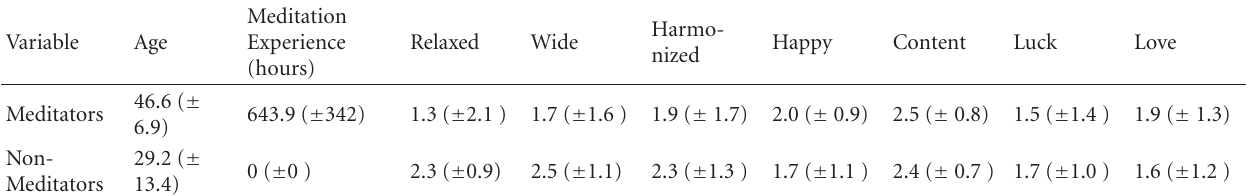
Figure 5: The upper left graph shows the total meditation experience for each of the 20 participants. The last 10 participants were non- meditators. The remaining 7 graphs show the ratings of the Sensorium session as a tendency towards the entitled emotional state. Zero means that there was no state change before and after the session. Negative values indicate a contrary e ff ect. Table 1: Quantitative statistical results of personal data and subjective ratings of the emotional e ff ect after a Sensorium session. The two groups meditators and non-meditators were separated in this